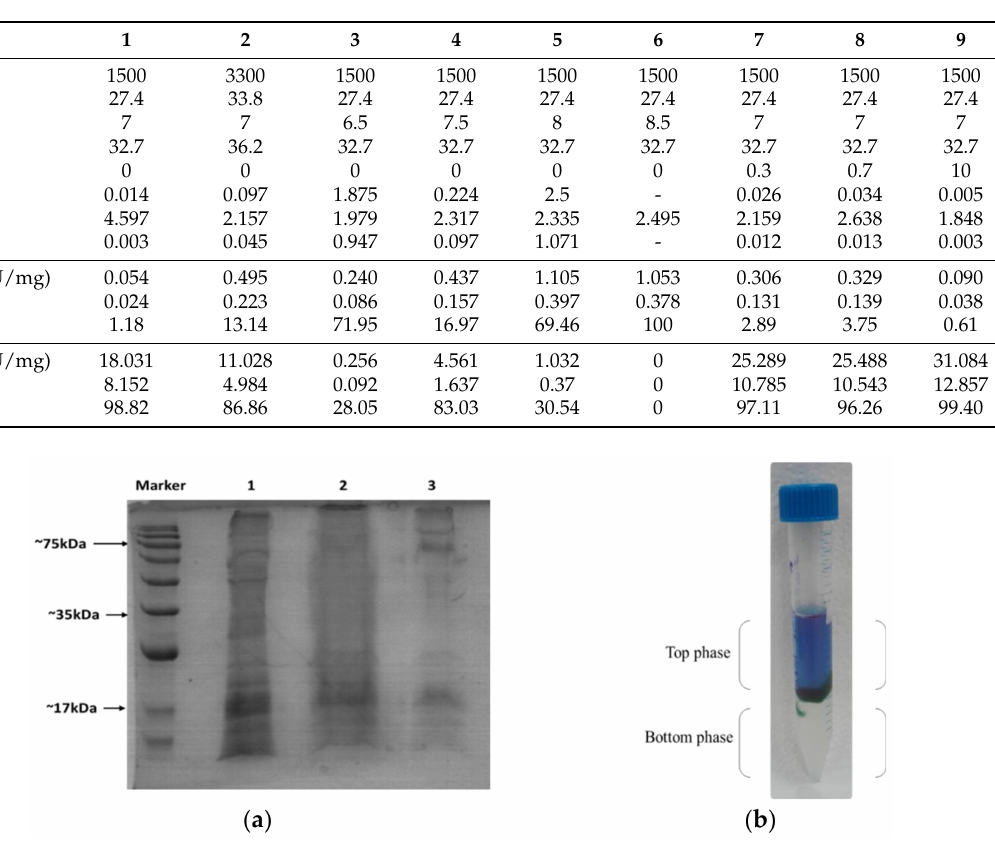
Table 1. ATPS experimental conditions (1–9) and obtained results of the partition and purification of the proteolytic activity of A. platensis lysate.